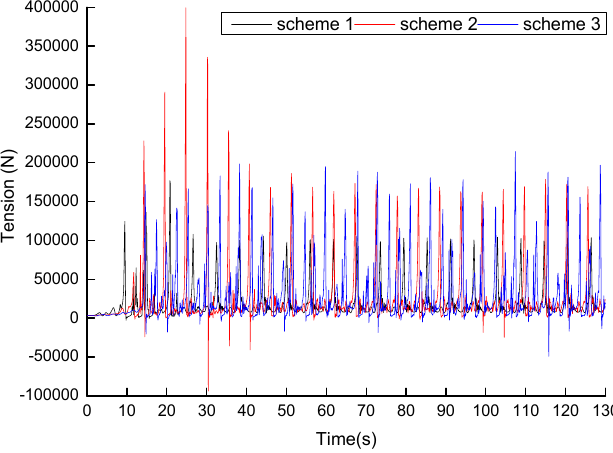
Figure 6. The stress of anchor chain 1 in schemes 1, 2, and 3. Anchor chains 3 and 4 are also symmetrically laid out, so the stress changes of the two chains are also similar, as shown in Figures 8 and 9. Floating of the device becomes stable after 30 s. The stress of the two chains in scheme 1 varies greatly, whereas their stress in scheme 3 varies moderately, and their stress in scheme 2 barely